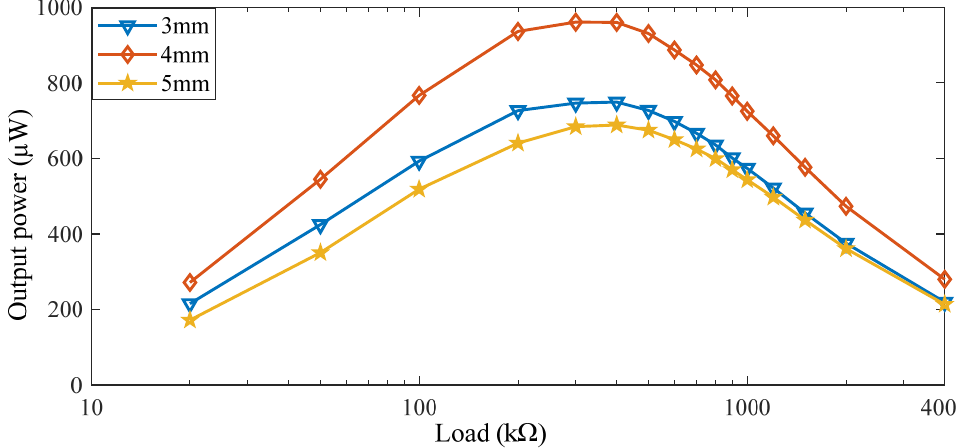
Figure 16. The output power under different hard block thicknesses.